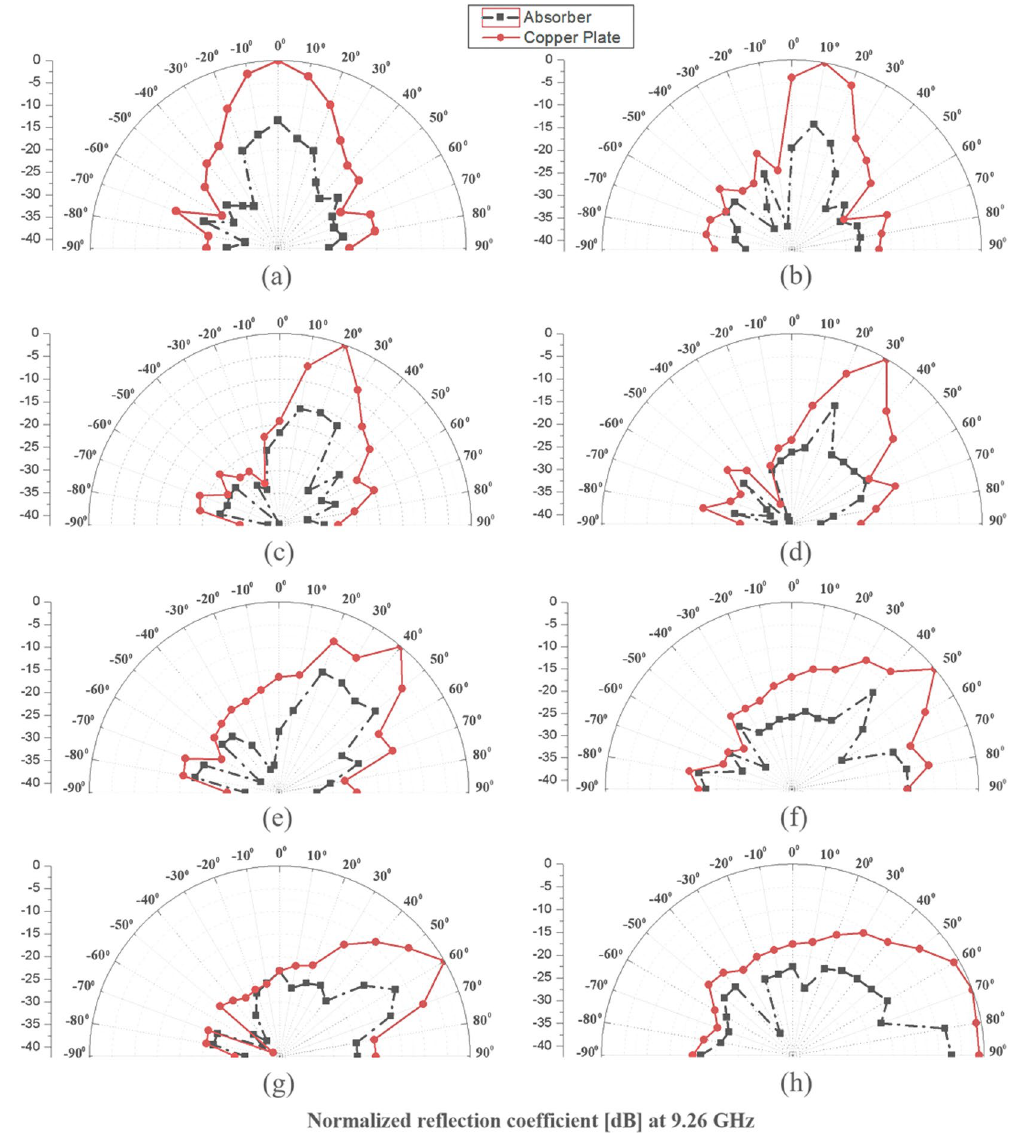
Figure. 8. Bistatic RCS measurement results at 9.26 GHz (a) for different incidence angles: ( a ) θ = 0°, ( b ) θ = 10°, ( c ) θ = 20°, ( d ) θ = 30°, ( e ) θ = 40°, ( f ) θ = 50°, ( g ) θ = 60°, and ( h ) θ = 70°.